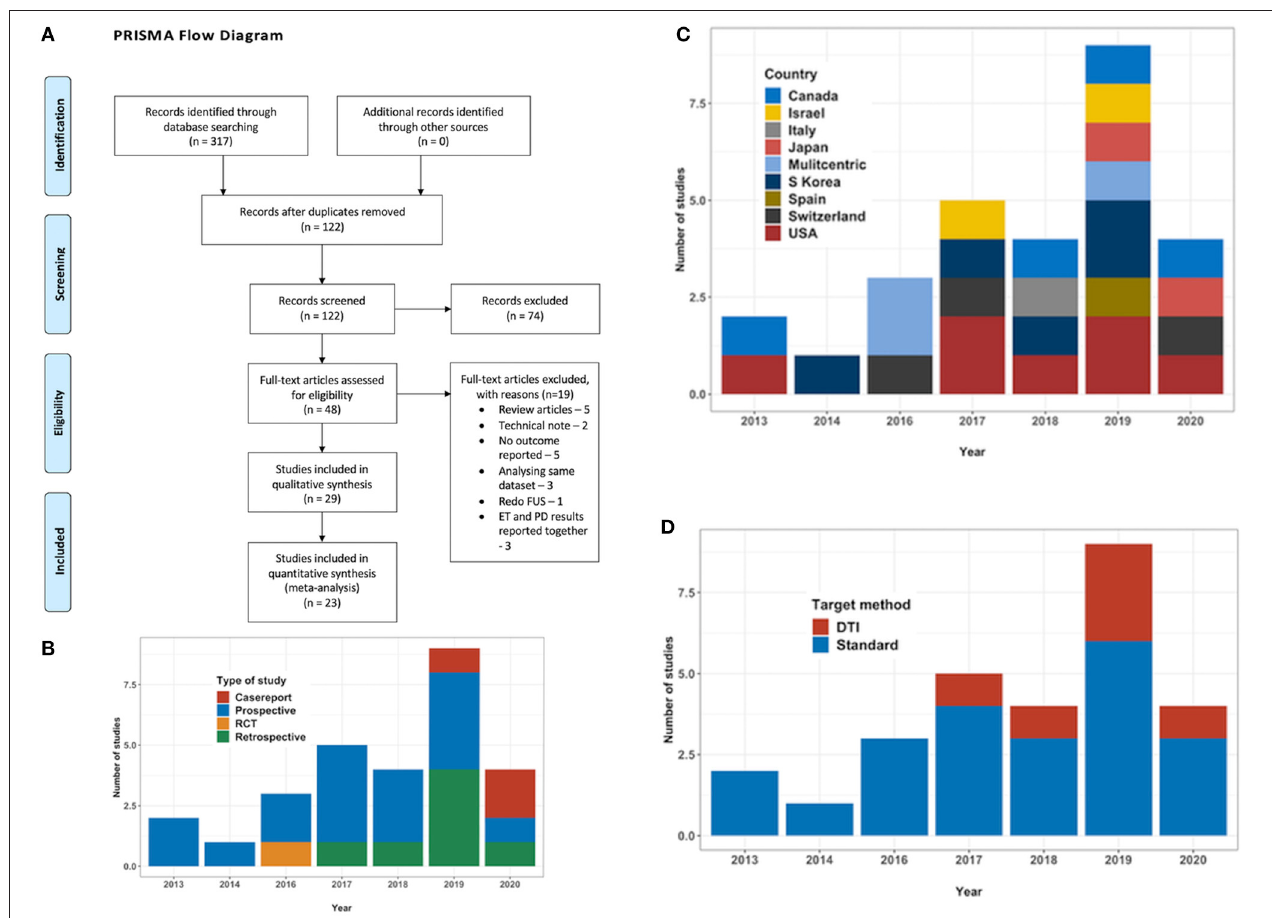
FIGURE 1 | (A) PRISMA flow diagram outlining the literature search process. (B) Bar chart depicting the type and number of studies with year of publication. (C) Bar chart depicting the country where the study was conducted. (D) Bar chart depicting the trend in targeting technique over the